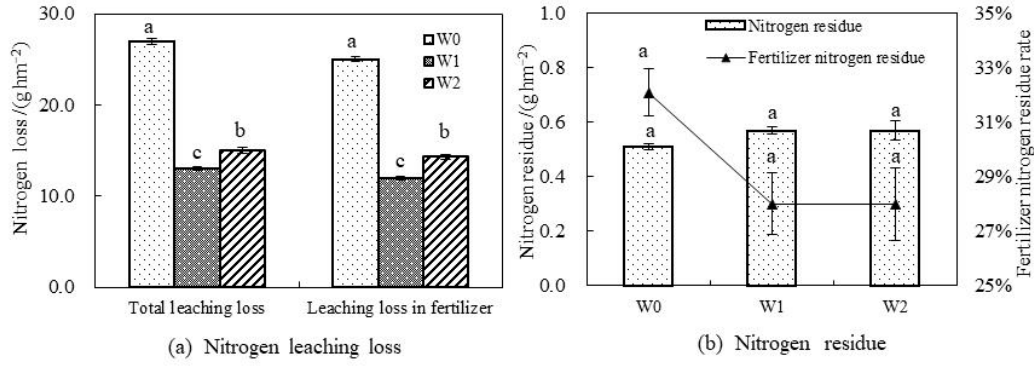
Figure 5. Differences between leaching amounts of soil nitrogen and fertilizer nitrogen under different irrigation modes, Figure a described nitrogen leaching loss and Figure b described nitrogen residue (a, b and c in the figure represented differences between groups for significance analysis).